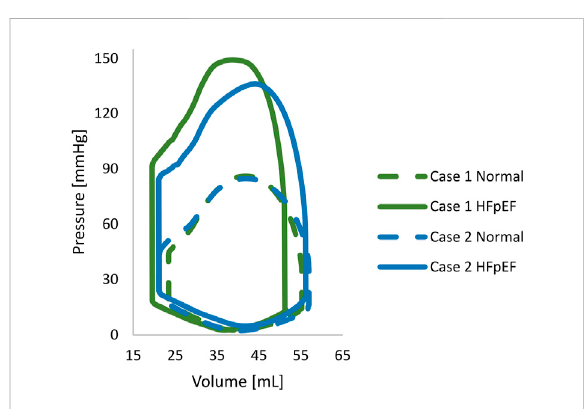
FIGURE 6 The pressure-volume loop of each porcine normal. The normal and HFpEF con fi gurations are denoted by continuous and dashed lines, respectively.